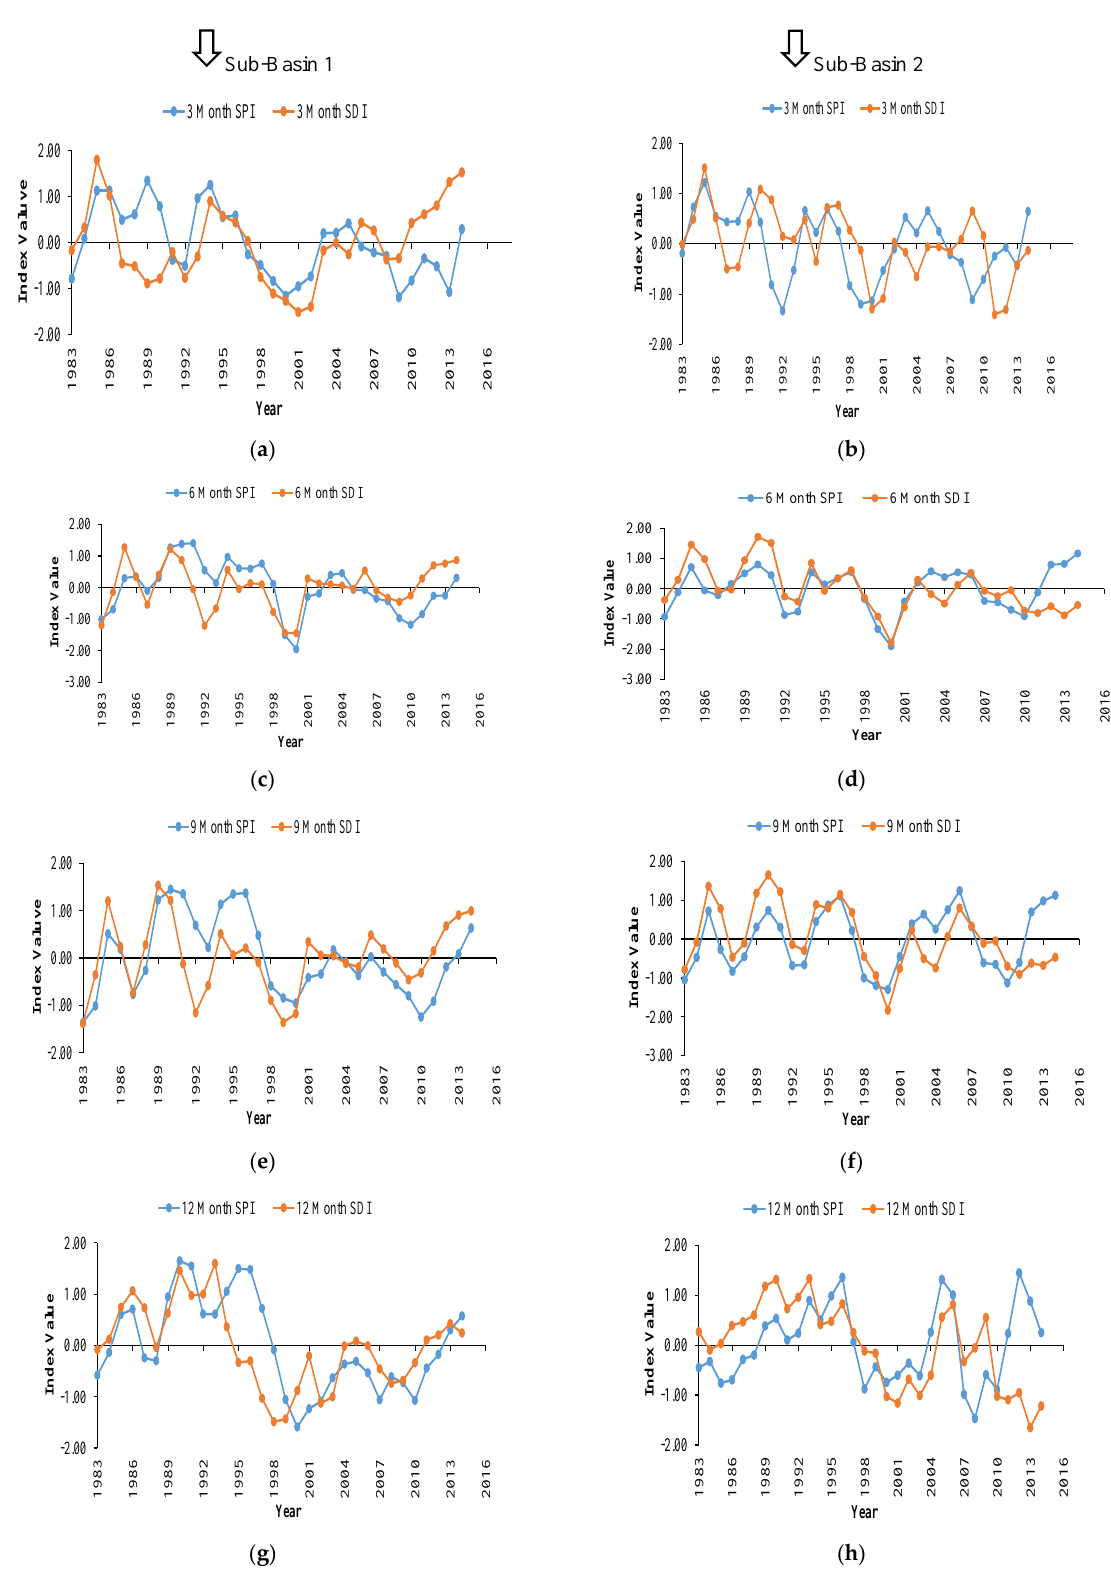
Figure 7. Moving average analysis for lag time identification between SPI and SDI at sub-basins 1 and 2 for different time scales. ( a , b ) 3 months, ( c , d ) 6 months, ( e , f ) 9 months, ( g , h ) 12